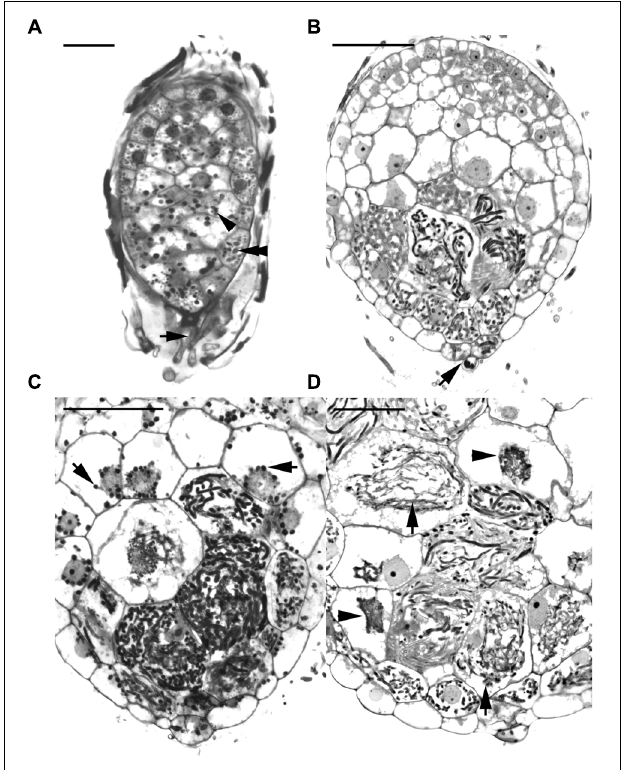
FIGURE 2 | Light micrographs of sections showing the successive developmental stages of D. officinale from seed germination to protocorm formation in symbiotic culture. (A) Stage 0, the uncolonized embryo covered by a thin seed coat in the first week of inoculation. The embryo cells filled with storage products, such as protein and lipid bodies. Scale bar = 50 µ m. (B) Stage 1, the infected embryo after 1 week of inoculation. Fungal hyphae have colonized the embryo and formed the pelotons (arrows) within embryo cells. Larger vacuoles make the embryo cells expand and the storage nutrients disappear from most embryo cells. Scale bar = 50 µ m. (C) Stage 2, the enlarged embryo with the rupture of the seed coat after 2 weeks of inoculation. The pelotons (arrows) locate in outer cortical cells and inner cortical cells of the spherical protocorm. Scale bar = 50 µ m. (D) Stage3, protocorm with the first crest and rhizoids after 3 weeks of inoculation. At this stage, the pelotons (arrows) are digested in the inner cortical cells. c, crest; r, rhizoid. Scale bar = 100 µ m.